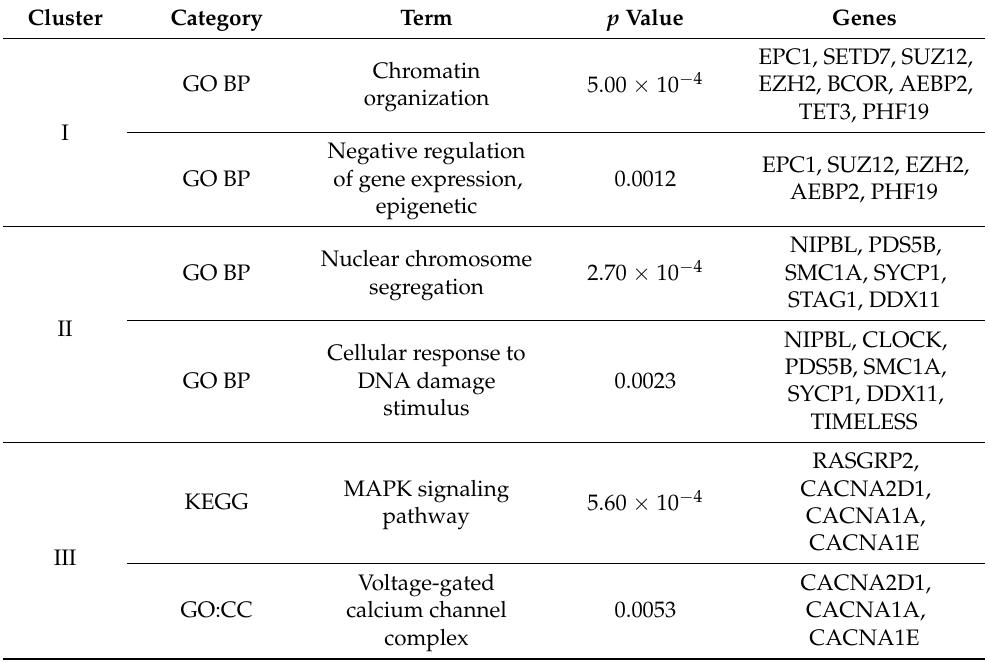
Figure 7. Results of protein–protein interaction analysis. The 6 top-scored clusters separated from the PPI network of the genes regulated by downregulated miRNAs found in the current study. The PPI hub gene module (g). Table 4. Enrichment analysis of the six top-scored clusters separated from the PPI network of the genes regulated by downregulated miRNAs found in the current study.